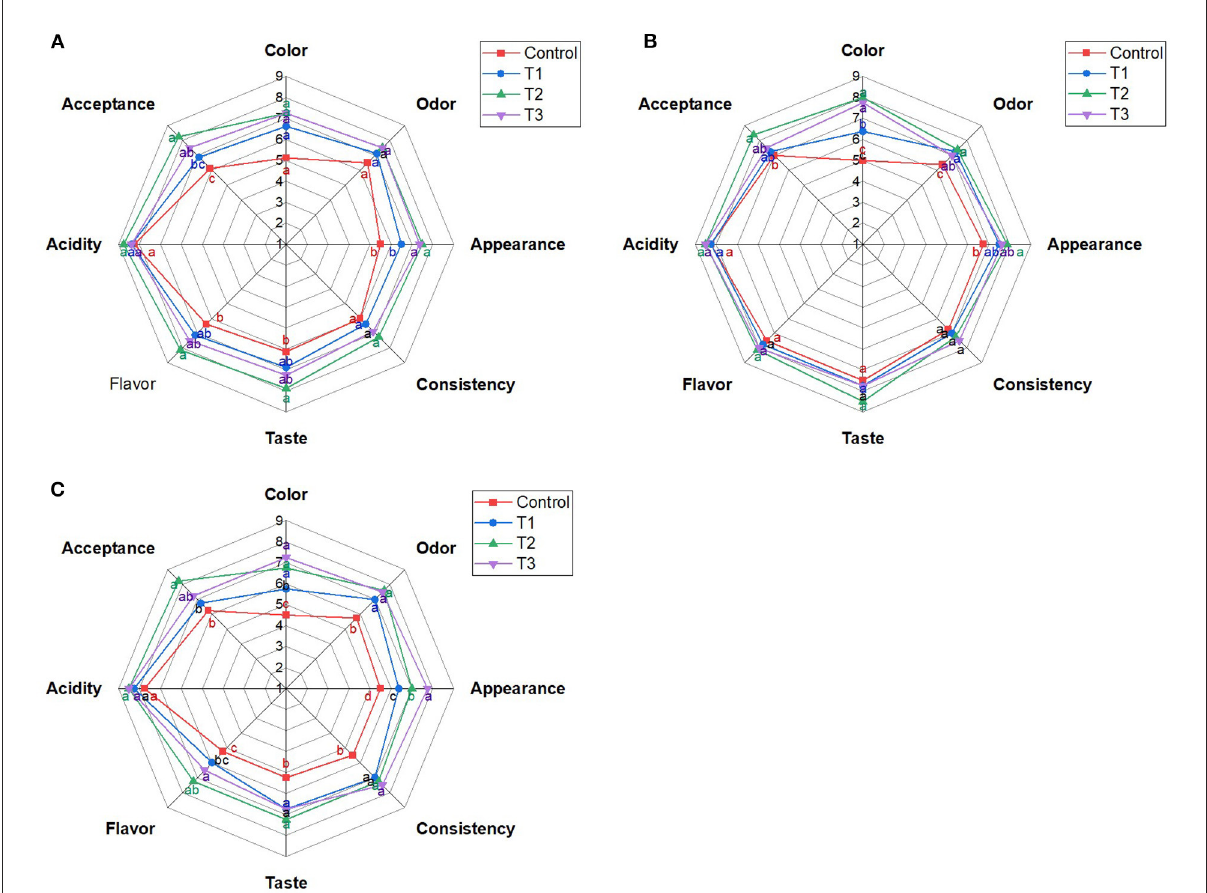
FIGURE1 Sensory attributes of whey/strawberry beverages enriched with different concentrations of beetroot peel water extract on day 0 (A) , day 7 (B) , and day 14 (C) of storage at 4 ◦ C. Means with different letters (a–d) for each sensory attribute are statistically different ( p <